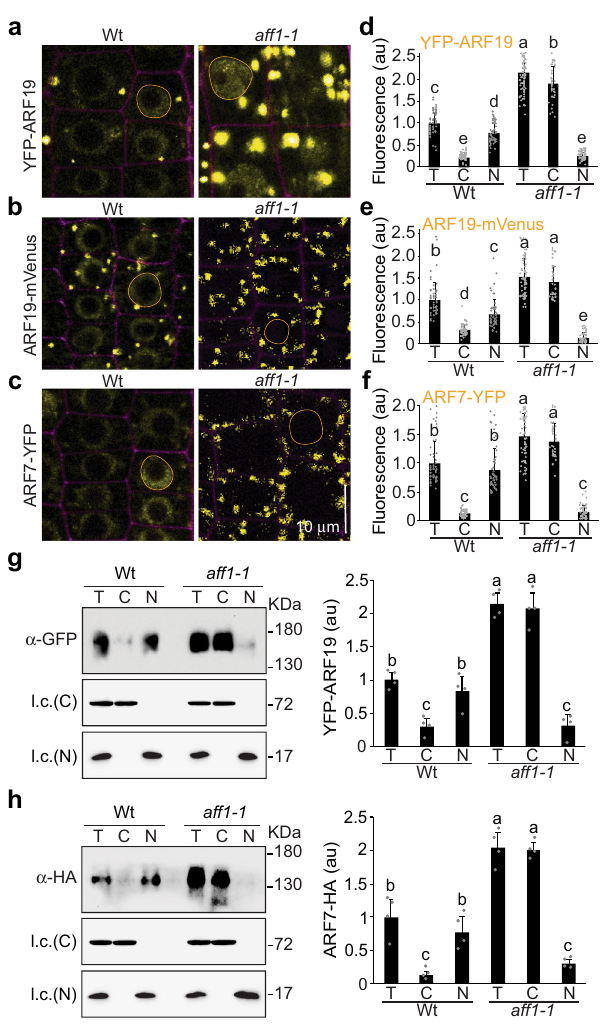
Fig. 2 AFF1 alters ARF19 and ARF7 nucleo-cytoplasmic partitioning. a Confocal images of root tip cells 3d-old Wt (Col-0) and aff1-1 seedlings carrying 35 S:YFP-ARF19 . b Confocal images of root tip cells 3d-old Wt (Col- 0) and aff1-1 seedlings carrying pARF19:ARF19-mVenus . c Confocal images of root tip cells 3d-old Wt (Col-0) and aff1-1 seedlings carrying pARF7:ARF7- YFP . For each confocal image, the ARF signal is false-colored yellow with cell walls counterstained with propidium iodide (false-colored magenta). In each image a representative nucleus is circled with an orange line. Scale bar = 10 µ m. d , e , f Quanti fi cation of subcellular fl uorescence of 3d-old Wt (Col-0) and aff1-1 seedlings carrying 35 S:YFP-ARF19 ( d ) , pARF19:ARF19- mVenus ( e ), or pARF7:ARF7-YFP ( f ) n = 63, n = 52 and n = 52 independent cells were examined in d , e and f , respectively. Data are mean ± SD of three independent experiments and gray dots represent the individual values. Different letters indicate individual groups for multiple comparisons with signi fi cant differences (one-way ANOVA, Duncan, p < 0.05). T (total), C (cytoplasmic), and N (nuclear). g Immunoblot analysis and quanti fi cation of YFP-ARF19 fractionation from 4d-old seedlings. h Immunoblot analysis and quanti fi cation of ARF7-HA fractionation from 4d-old seedlings. HSC70 and histone H3 served as loading controls (l.c.) for the cytosol (C) and the nucleus (N), respectively. Data in g and h are mean ± SD from four independent experiments and gray dots represent the individual values. Different letters indicate individual groups for multiple comparisons with signi fi cant differences (one-way ANOVA, Duncan, p < 0.05). The source data in d , e , f , g and h are provided as a Source Data fi